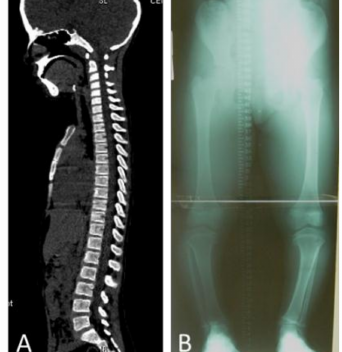
Figure 3. ( A ) 3DCT scan of the vertebral column (mid-sagittal) of a 17-year-old girl showed odontoid hypoplasia and square-shaped vertebral bodies with marked anterior end-plate dysplasia of the T9-11. ( B ) AP radiograph of the lower limbs (telemetric) in a 15-year-old girl showed leg shortening relative to the thigh, and metaphyseal widening of the inferior femora and the superior tibiae e ff ectively causing the development of genu